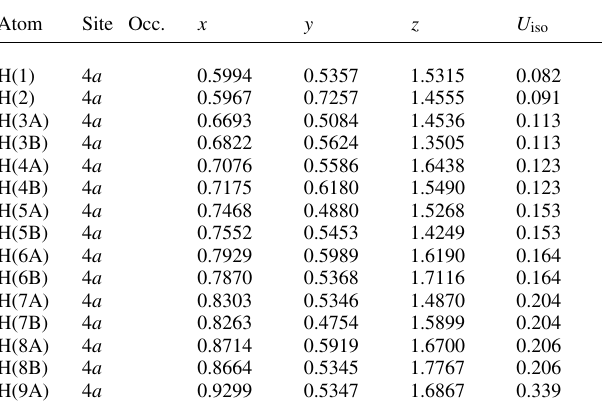
Table 2. Atomic coordinates and displacement parameters (in Å 2 ) .